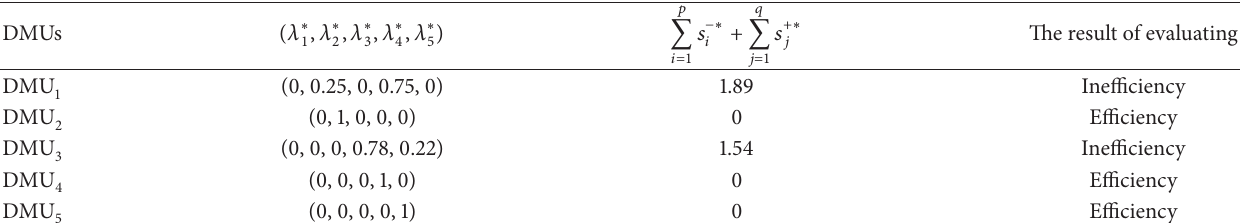
Table 2: Results of evaluating the DMUs with 𝛼 = 0.6